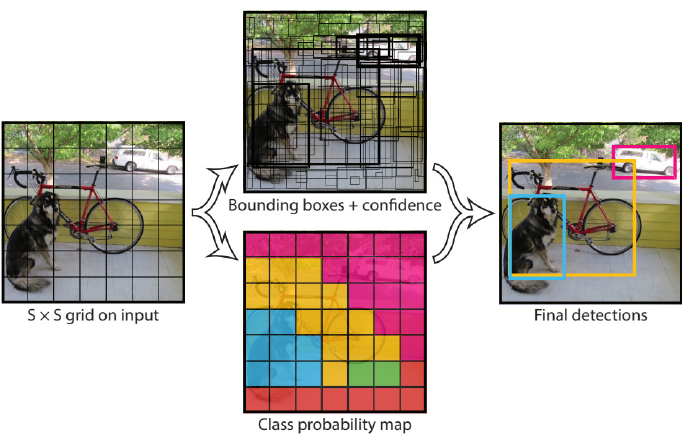
Figure 1. Structure of the YOLO.